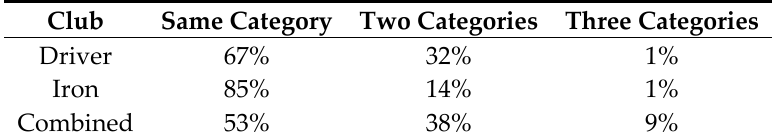
Table 4. Highlighting whether people stay in the same category of primary force production between shots.